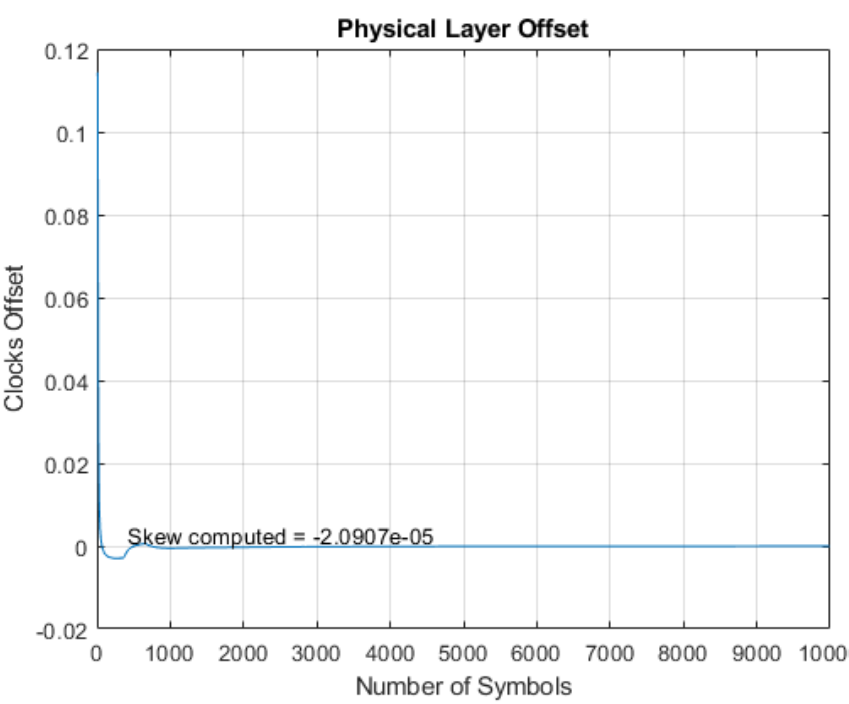
Figure 13. Fractional offset µ .